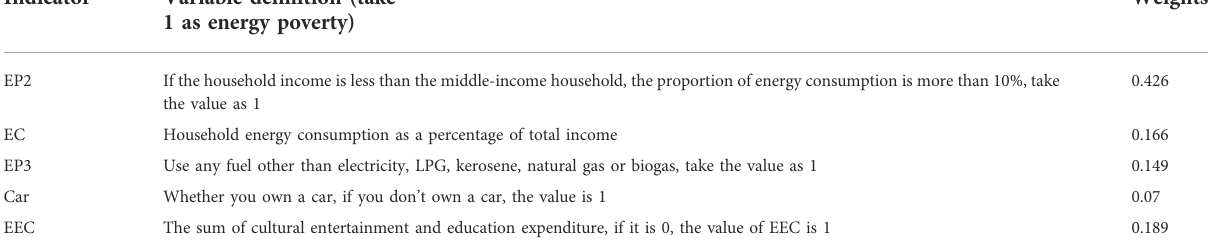
TABLE 1 MEPI construction system: De fi nition, weights, statistics. Indicator